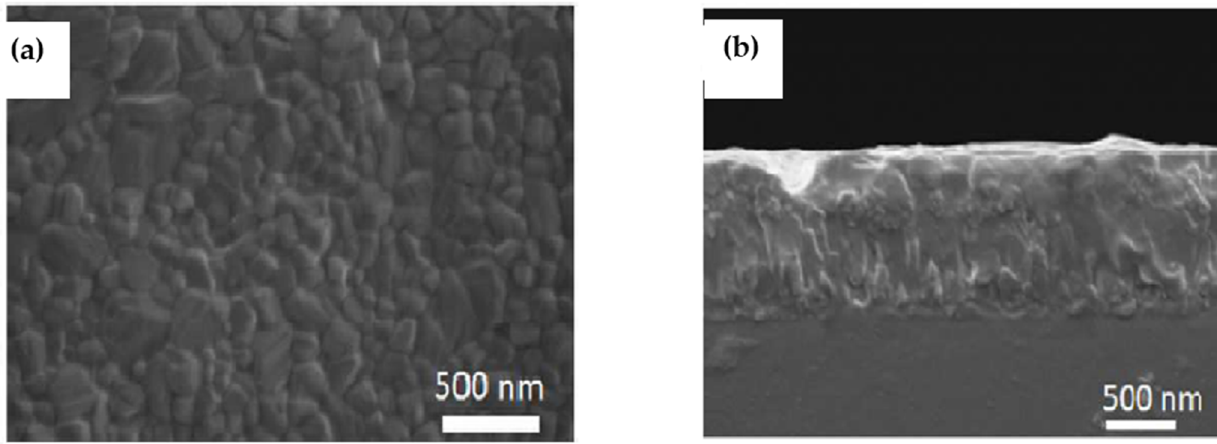
Figure 12. ( a ) Top-view SEM image of obtained Cs 2 AgBiBr 6 film by spin coating at room temperature using the anti-solvent treatment with chlorobenzene; ( b ) cross-section SEM image of FTO/c-TiO 2 /m-TiO 2 /double perovskite sample, upon annealing at 280 °C. Reproduced with permission from [80] . Copyright 2018, American Chemical Society.